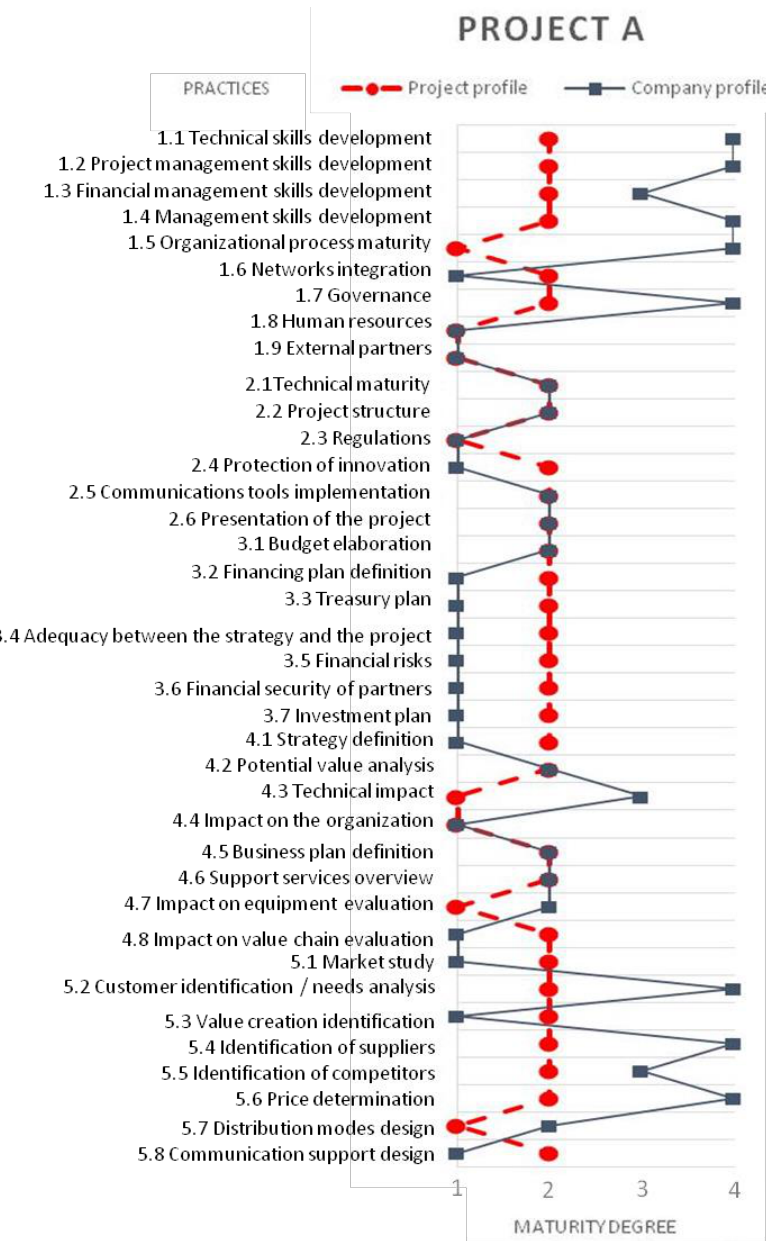
Figure 5. Comparison between the maturity profile of the company’s technology system and the profile required by project